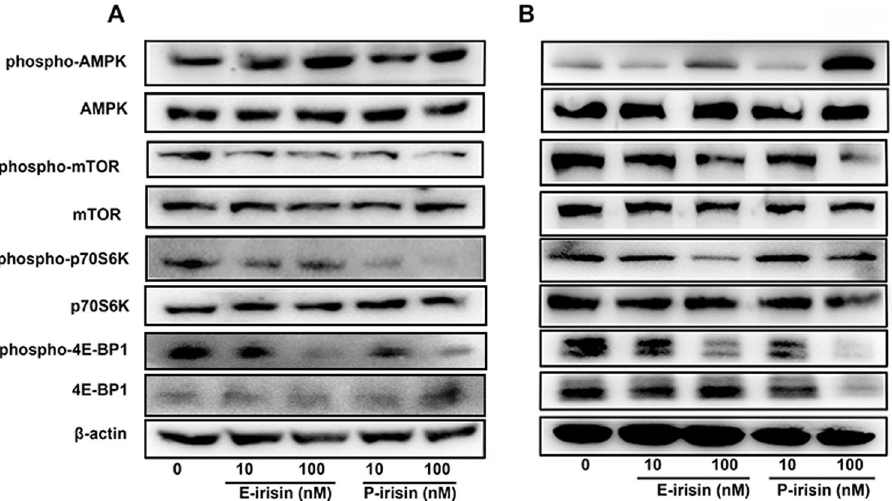
Figure 4. Irisin-mediated activation of the AMPK-mTOR pathway. The phosphorylated (Thr172) and total AMPK, phosphorylated (Ser2448) and total mTOR, phosphorylated (Thr389) and total p70S6 kinase, and phosphorylated (Thr37/46) and total 4E-BP1 proteins of MIA PaCa-2 ( A ) and Panc03.27 ( B ) cells were detected using Western blotting analysis after treatment with E-irisin or P-irisin for 24 h. β -actin was used as the loading control, the original full-length Western blot images are showed in Supplementary Fig.